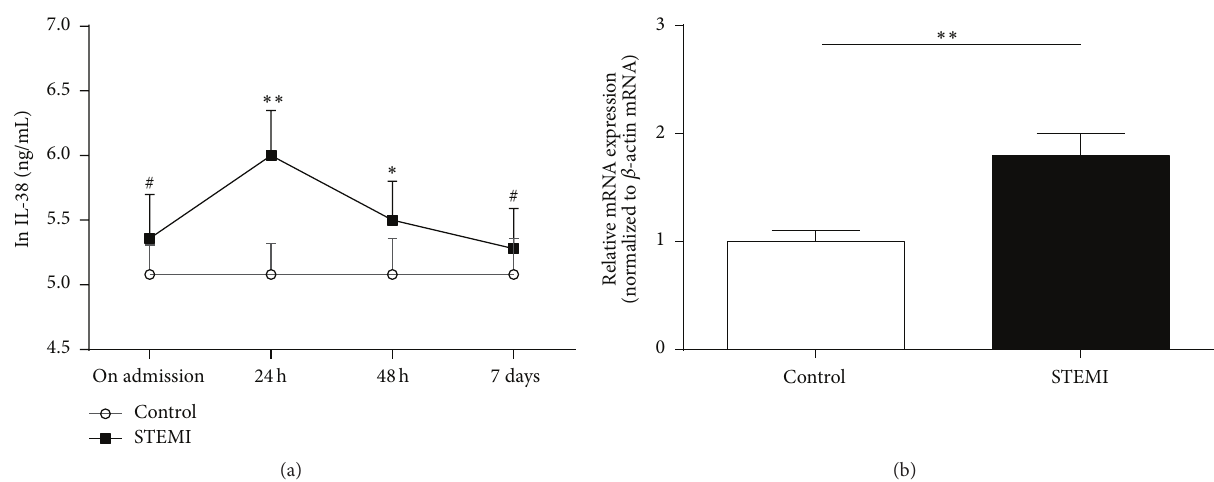
Figure 1: The IL-38 protein in plasma and IL-38 gene in PBMCs of STEMI patients. (a) Plasma IL-38 from STEMI patients. IL-38 protein was qualified by ELISA kit at different time-point. The statistical analysis is performed after ln transformation. (b) The IL-38 gene in PBMCs of STEMI patients. IL-38 gene expression was detected with RT-PCR at 24h. STEMI: ST-segment elevation myocardial infarction; Control group: chest pain syndrome. Data are presented as mean ± SD. # 𝑃 > 0.05 , ∗ 𝑃 < 0.05 , and ∗∗ 𝑃 < 0.01 versus